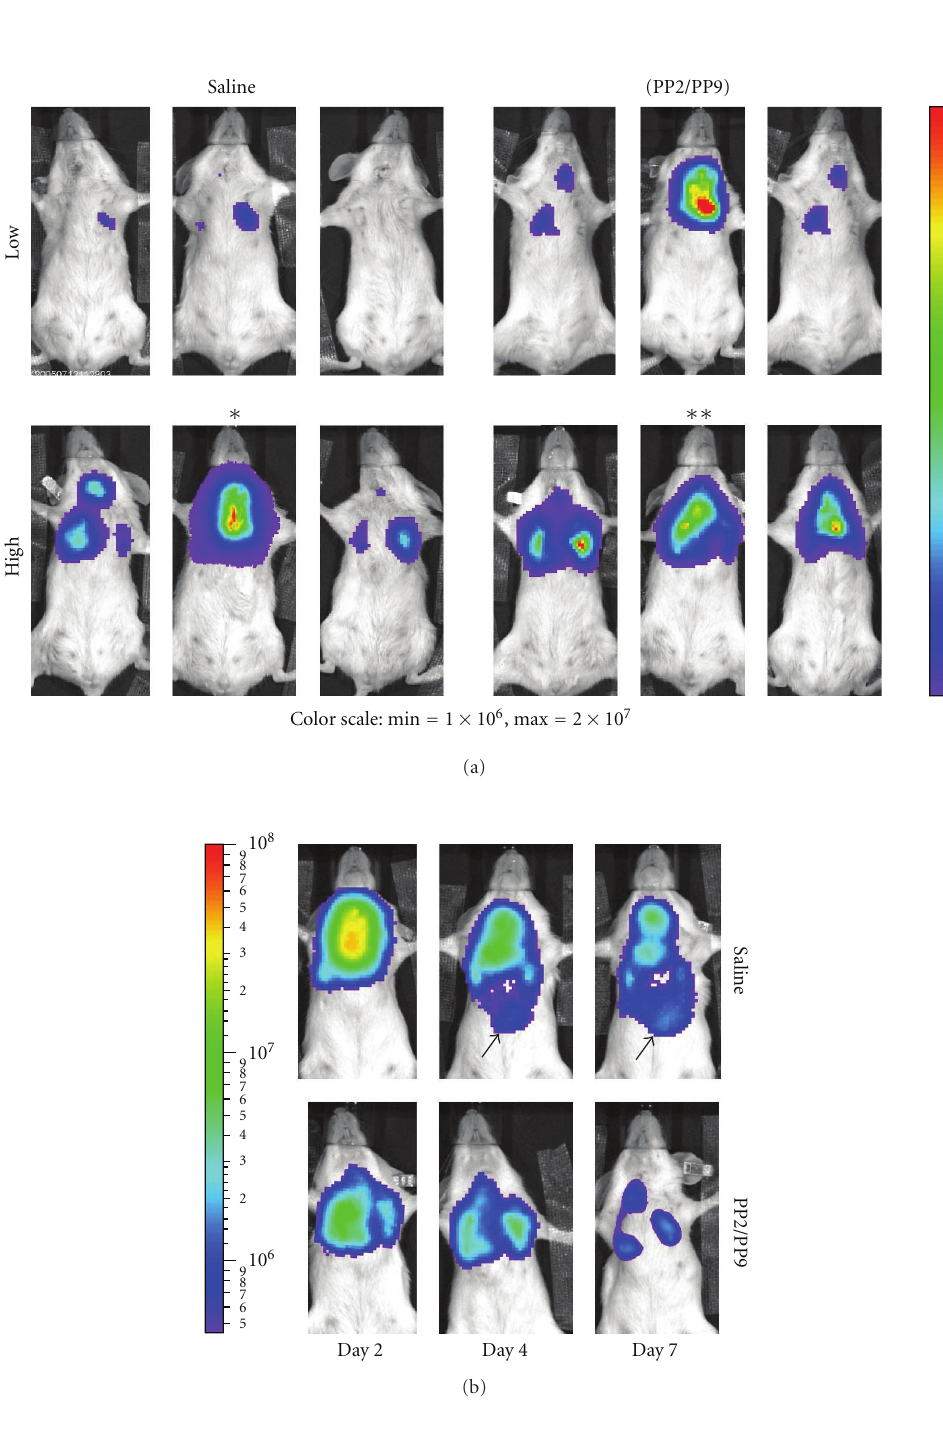
Figure 3: Comparison of spatial distribution of rAd-saline and -PP2/PP9 suspensions. (a) Expression at 1d after instillation. Overlay of photographs and luminescent images of three representative animals per group. Mice were instilled with 5 × 10 10 viral particles of rAd.luc suspended in either saline (left) or PP2:PP9 suspension (right) as described in Materials and Methods. The images were acquired 10min after intraperitoneal delivery of luciferin (100 μ L; 150 mg/kg). Luminescent images were acquired under identical settings (3min acquisition). Images from day 1 are scaled linearly with the range of signal indicated. Asterisks denote animals whose images are shown at later time points in panel (b). (b) Delivery with PP2/PP9 results in better retention in the lung. Overlay of photographs and luminescent images of representative animals from the high-dose groups is denoted in panel (a). The mice were imaged on successive days after instillation as indicated. Images are scaled logarithmically (note scale on the